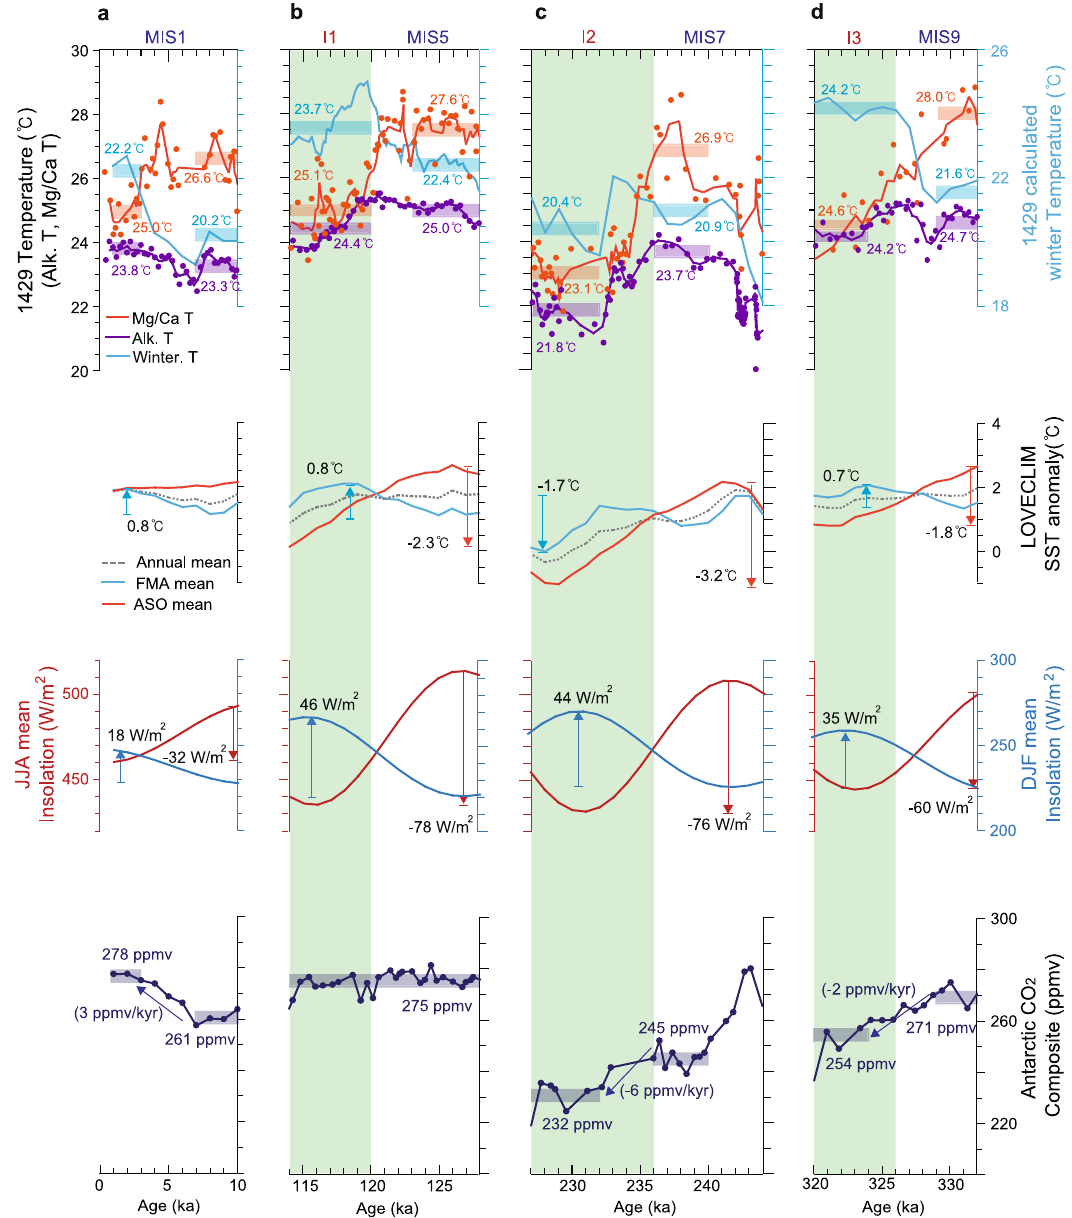
Fig. 6 Reconstructed sea surface temperatures (SST) over the last four interglacials. Variations in proxy SSTs at Site U1429, LOVECLIM model SSTs, insolation for June to August and for December to February at the latitude of Site U1429 (31.6°N), and Antarctic composite CO 2 concentration 49 for